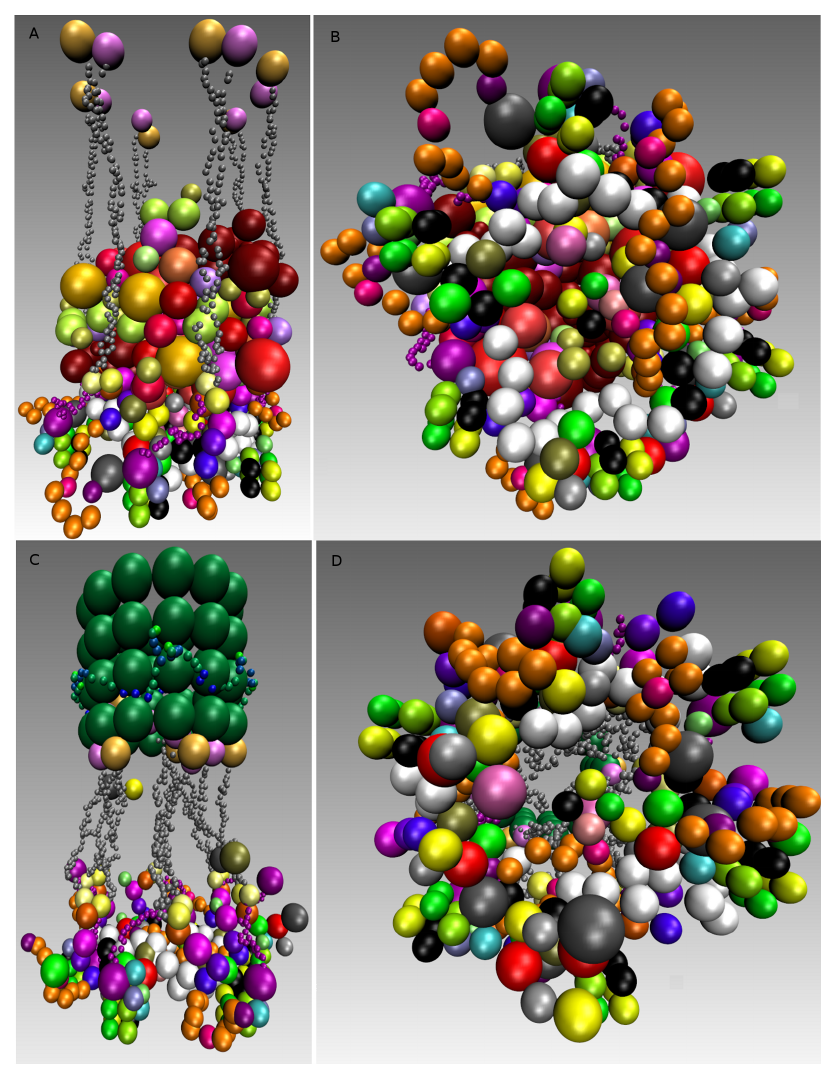
Figure 9. Single rosette-like structure assembly in mitosis. ( A ) Shows a rosette-like structure where SACis active and no microtubule is present or attached; ( B ) Same as in Panel A, showing the rosette-shape in top view; ( C ) Shows a rosette-like structure attached to a microtubule and including the Ska complex, where the Spindle Assembly Checkpoint (SAC) switched off; ( D ) Same as Panel A, showing the rosette-shape in top view similar to Panel B, while SAC is inactive. The distance between two nucleosomes is 14 nm , and consequently, the diameter of the rosette-shape and microtubule is 25 nm . The rosette-structure and the Ska-complex are 60 nm apart. The attached, as well as the unattached kinetochore took about one hour to